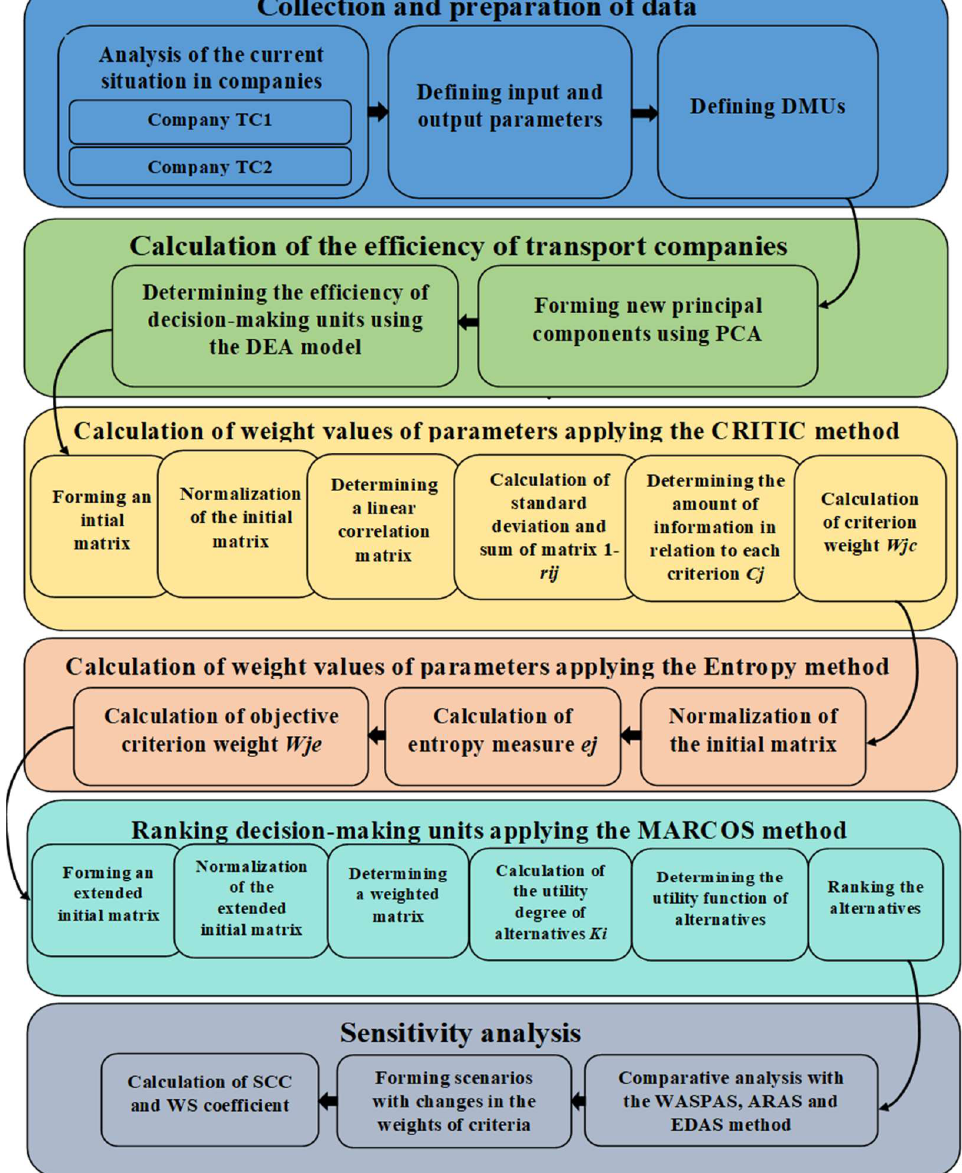
Figure 1. Applied methodology.